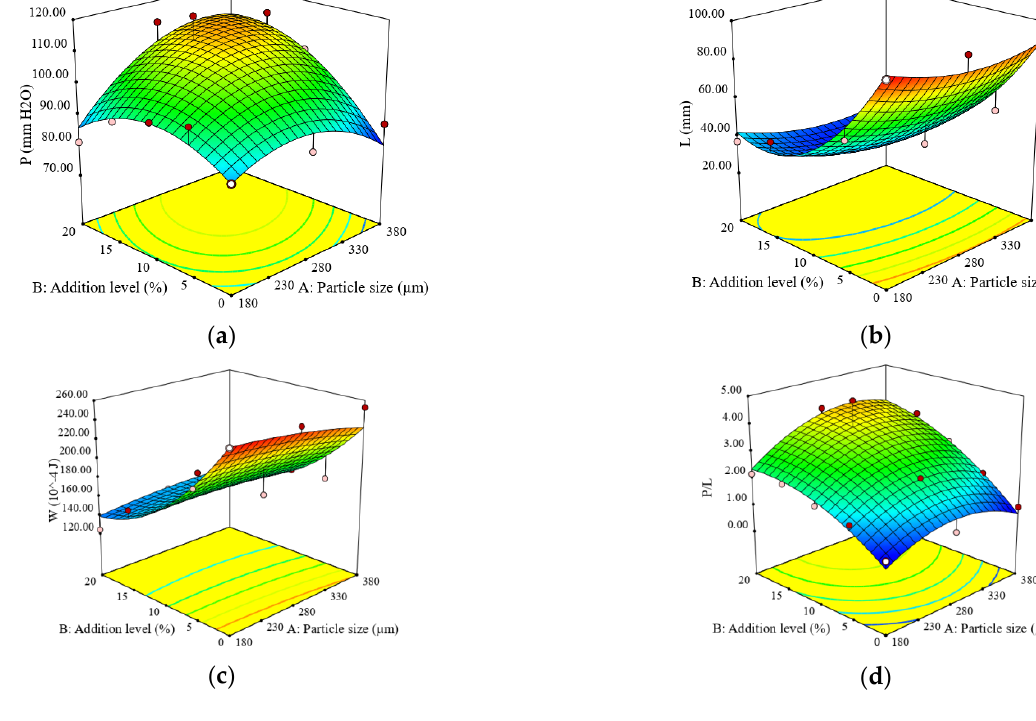
Figure 3. 3D response surface graphic presenting the effect of quinoa flour particle size and addition level on: ( a ) dough tenacity (P); ( b ) dough extensibility (L); ( c ) deformation energy (W); ( d ) alveograph ratio (P/L).